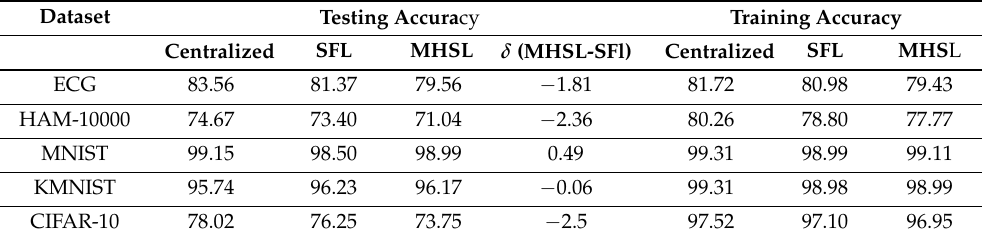
Table 5. Training and testing accuracy for centralized, SFL and MHSL architectures.